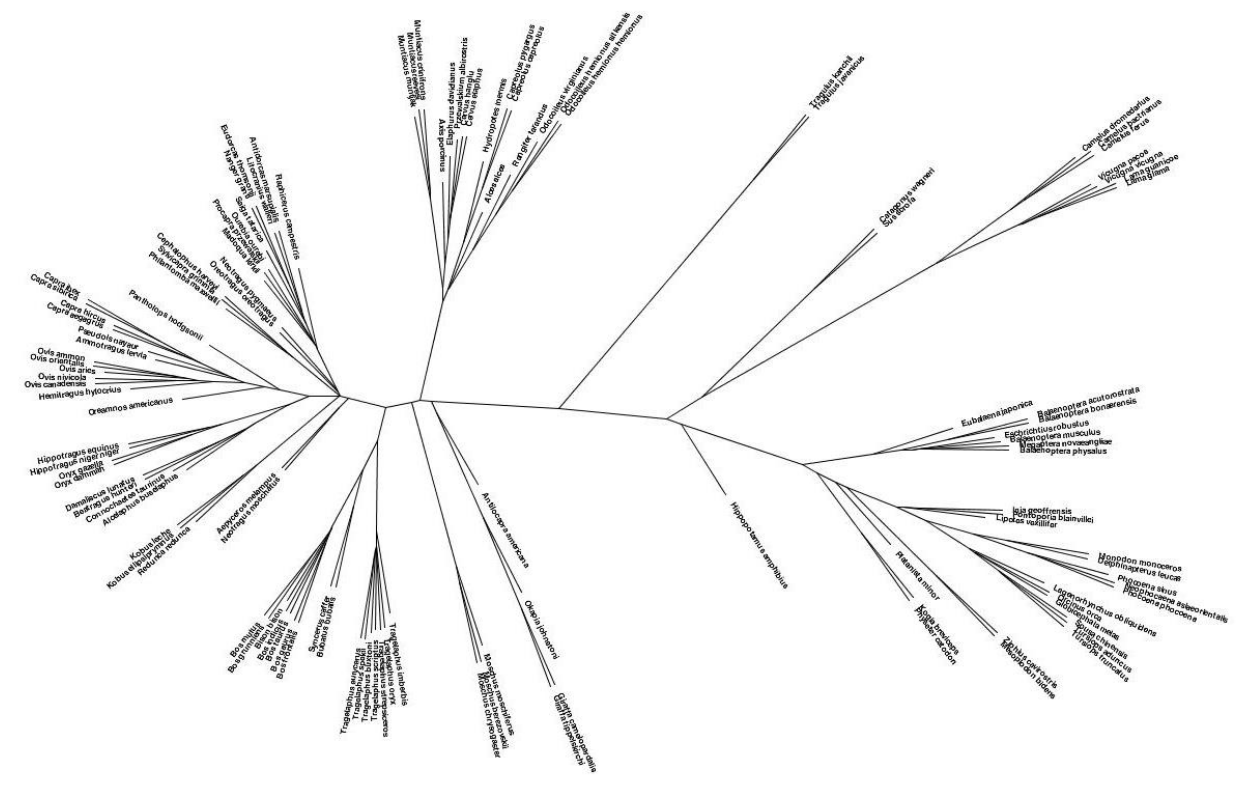
Figure 1. Species tree derived from individual prohomone gene trees.